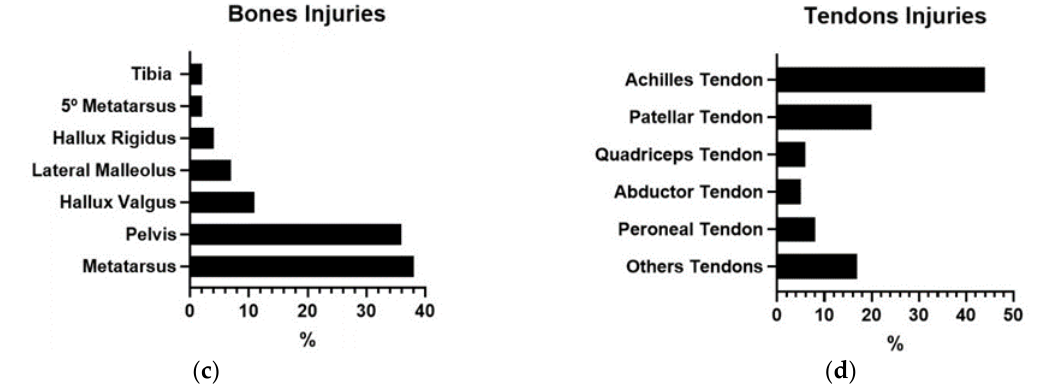
Figure 2. ( a – d ) Type of pathology in the lower limb based on the tissue injured.